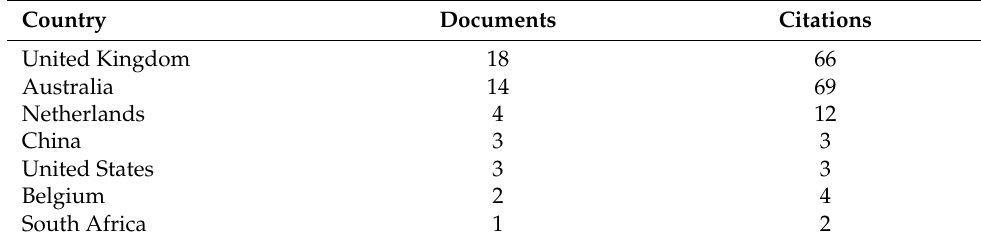
Table 8. Country of origin analysis of the retrieved